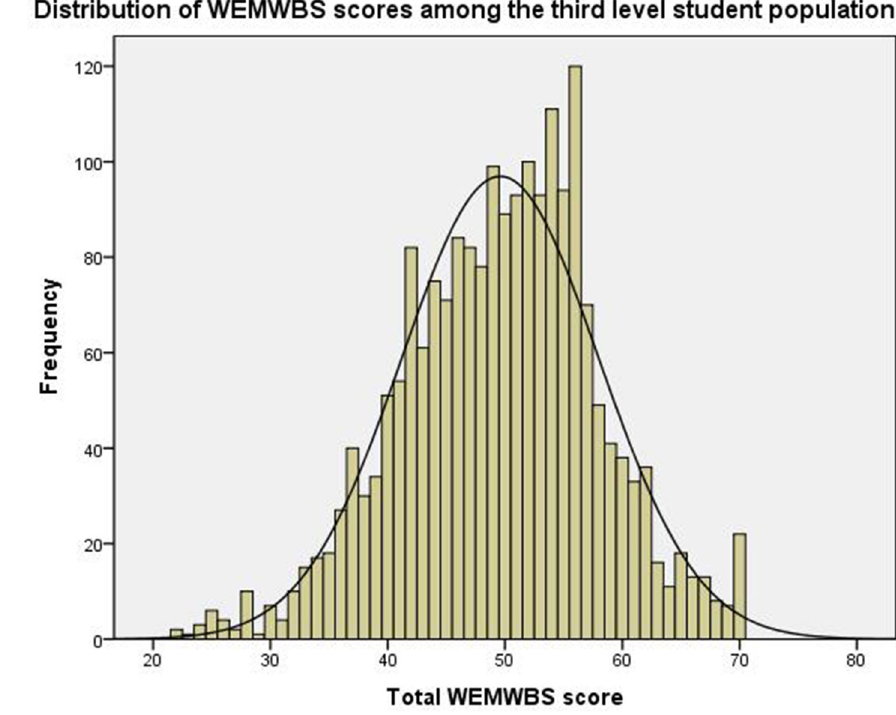
Figure 1. Distribution curve for WEMWBS scores among a third level student population. doi: